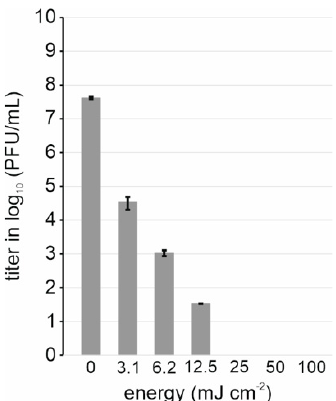
Figure 2. Inactivation of SARS-CoV-2 infectivity by UV. Titers of SARS-CoV-2 after treatment with indicated amounts of UV energy are represented with bars. Bar plot represents data from three independent experiments.